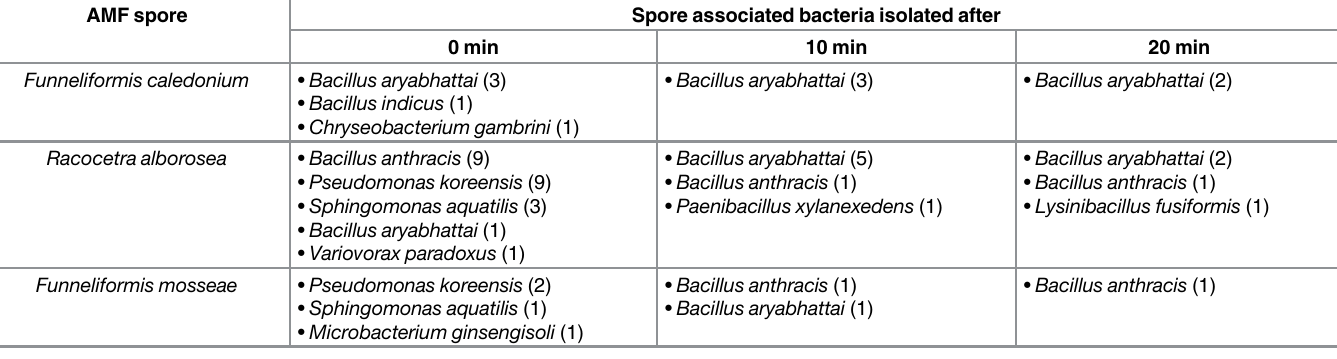
Number in the parenthesis indicates the number of